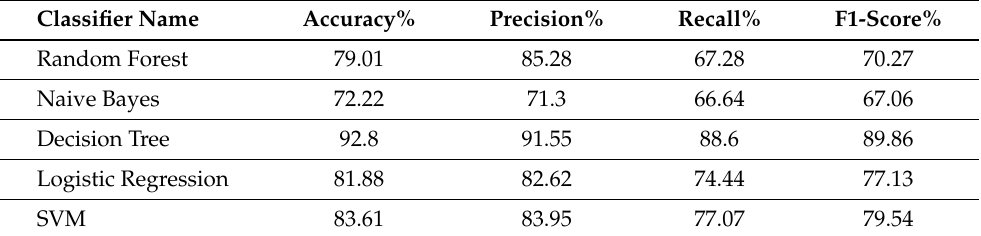
Figure 8. Confusion matrix for Sinovac Dataset ( a ) using Random Forest ( b ) Naive Bayes ( c ) Decision Tree ( d ) Logistic Regression ( e ) SVM. Table 6. Machine learning performance on Sinovac vaccine